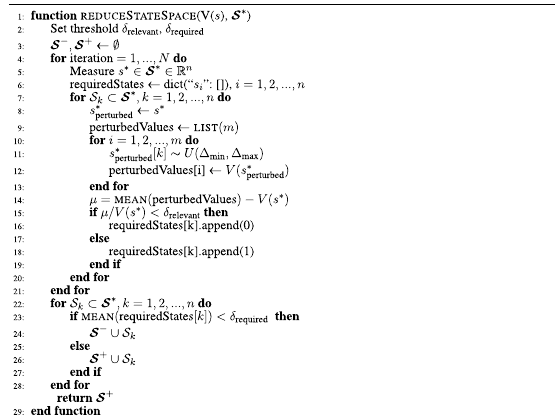
Algorithm 2. Pseudo code for selecting relevant state